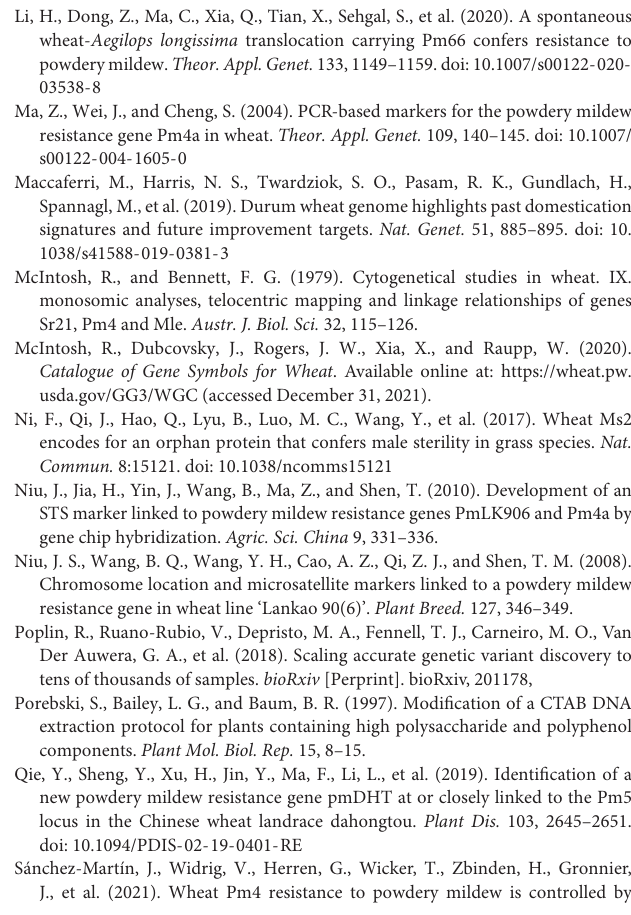
Supplementary Table 1 | Closely linked markers for several reported powdery mildew resistance genes on chromosome